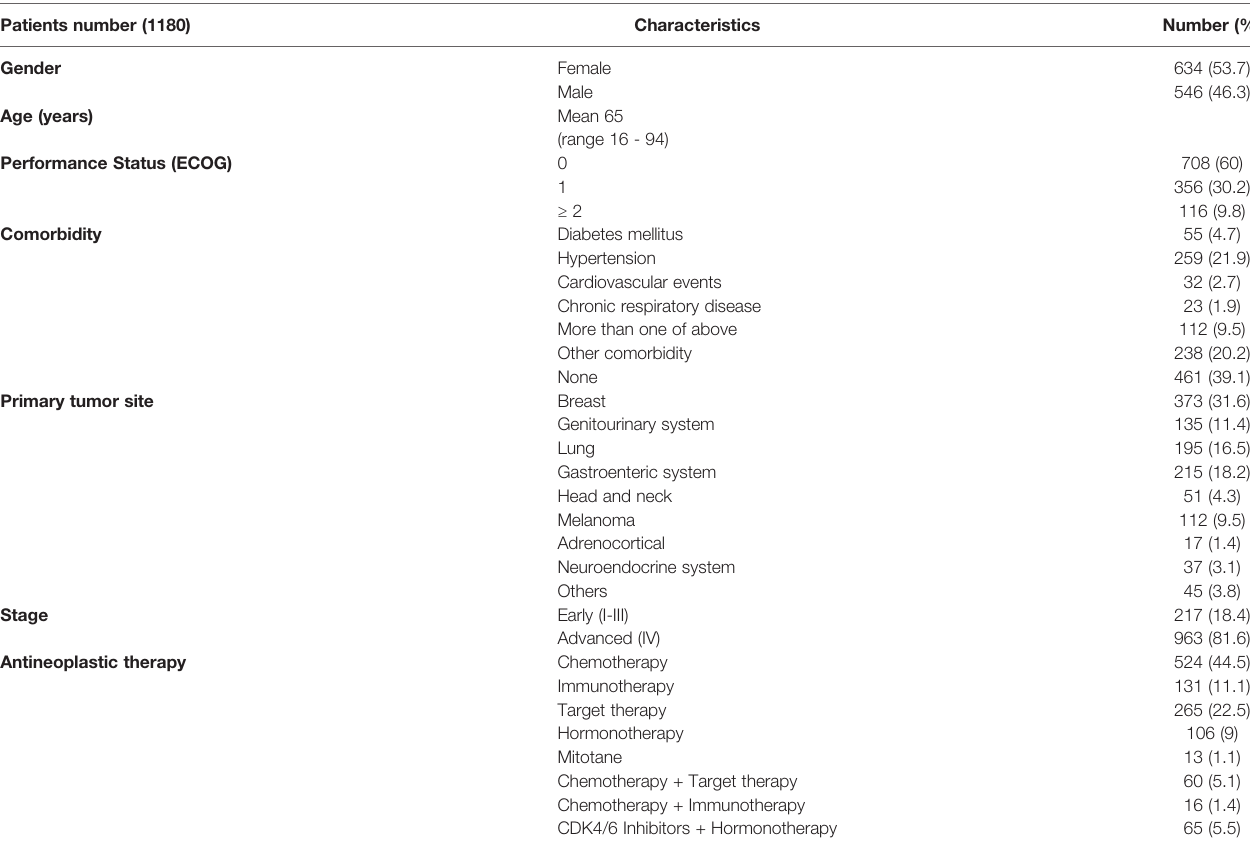
TABLE 1 | Clinical and demographical characteristics of 1180 enrolled patients. Patients number